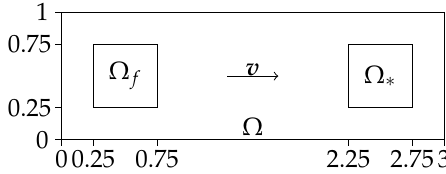
Figure 3. Geometry of Ω for the convection–diffusion Problem